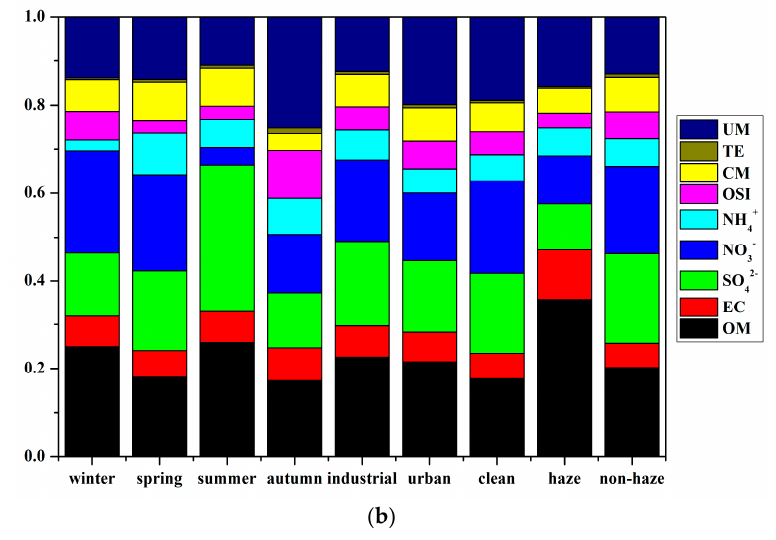
Figure 4. Chemical species contributed to the total PM 2.5 mass concentrations during the entire sampling period ( a ). Chemical species contributed to the total PM 2.5 mass concentrations at different seasons and different sites, as well as haze or non-haze days ( b ). Abbreviations: organic matter (OM), crustal materials (CM), sulfate (SO 42 − ), nitrate (NO 3 − ), ammonium (NH 4+ ), elemental carbon (EC), soluble ions except sulfate, nitrate and ammonium (O(ther)SI), trace elements (TE), and unidentified matter (UM).